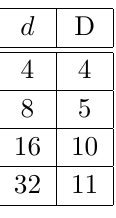
Table 1. Relation Between D (Number of Spacetime) Dimensions and d For Some Superspaces.